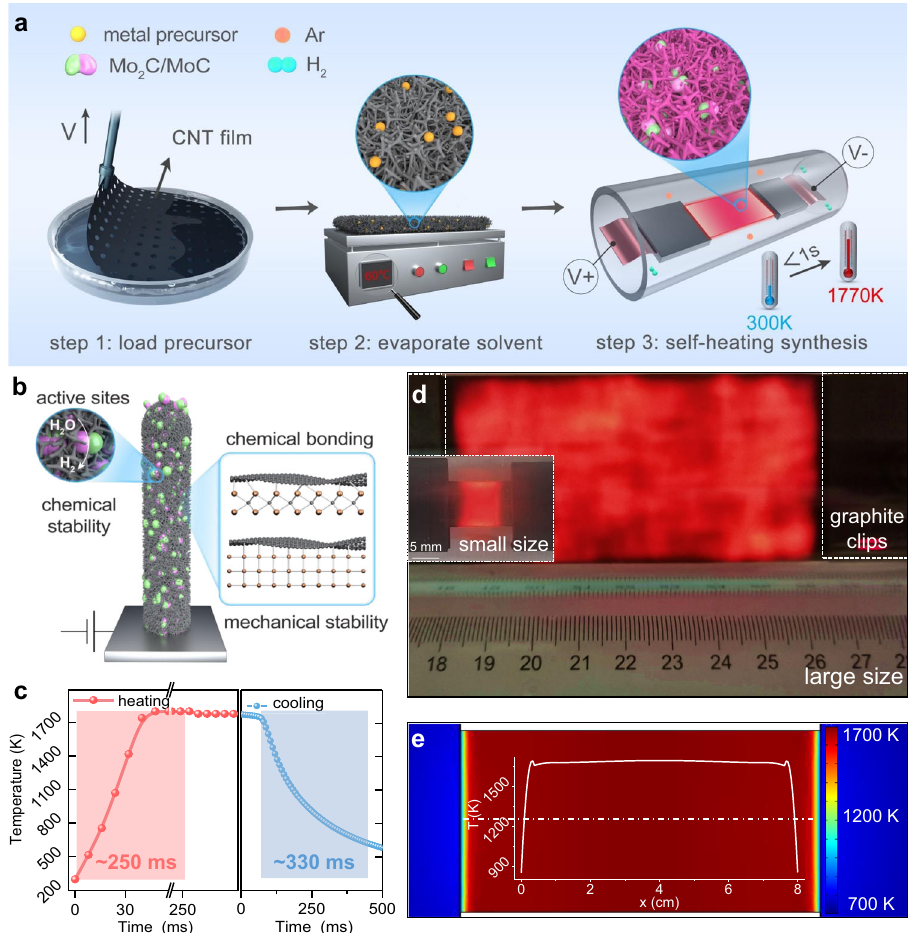
Fig. 1 Ultrafast self-heating synthesis. a Schematic illustration of the synthesis of Mo 2 C/MoC/CNT fi lms by the self-heating method. b Mo 2 C/MoC/CNT fi lm as an HER electrode. c Temperature-Time curve of heating (left) and cooling (right) process during self-heating. d Optical pictures of the CNT fi lm at high temperature in a large size (80 mm × 40 mm) and a small size (15 mm × 8 mm, inset). e Simulation of temperature distribution (colour contour) at ~1700 K via COMSOL Multi-Physics software for the large-size fi lm. The top-layer curve shows the temperature distribution along the